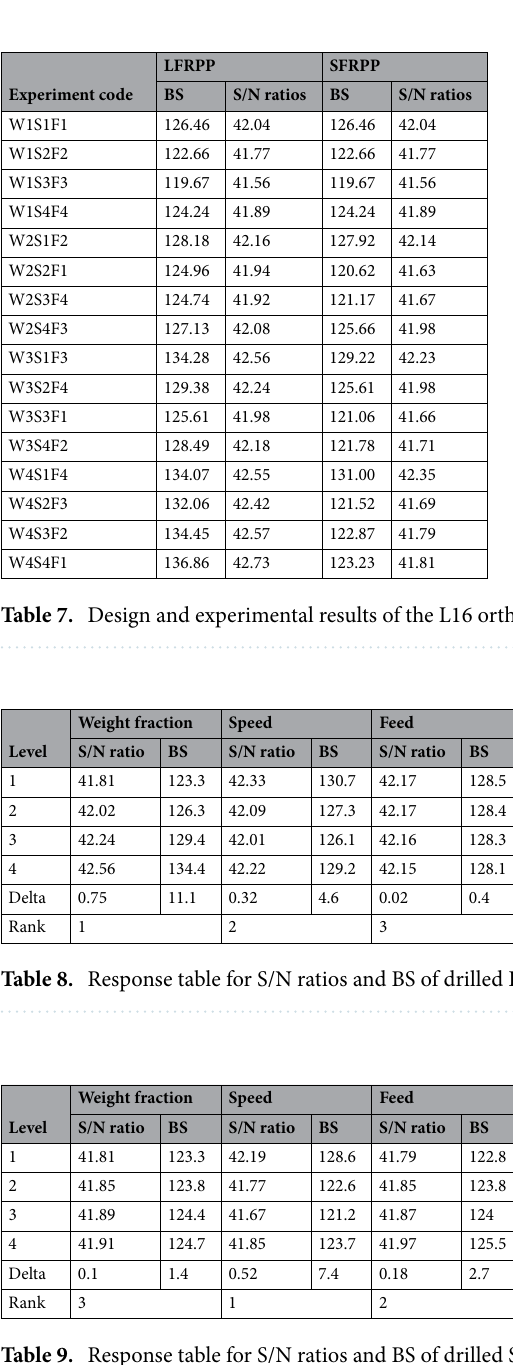
Table 9. Response table for S/N ratios and BS of drilled